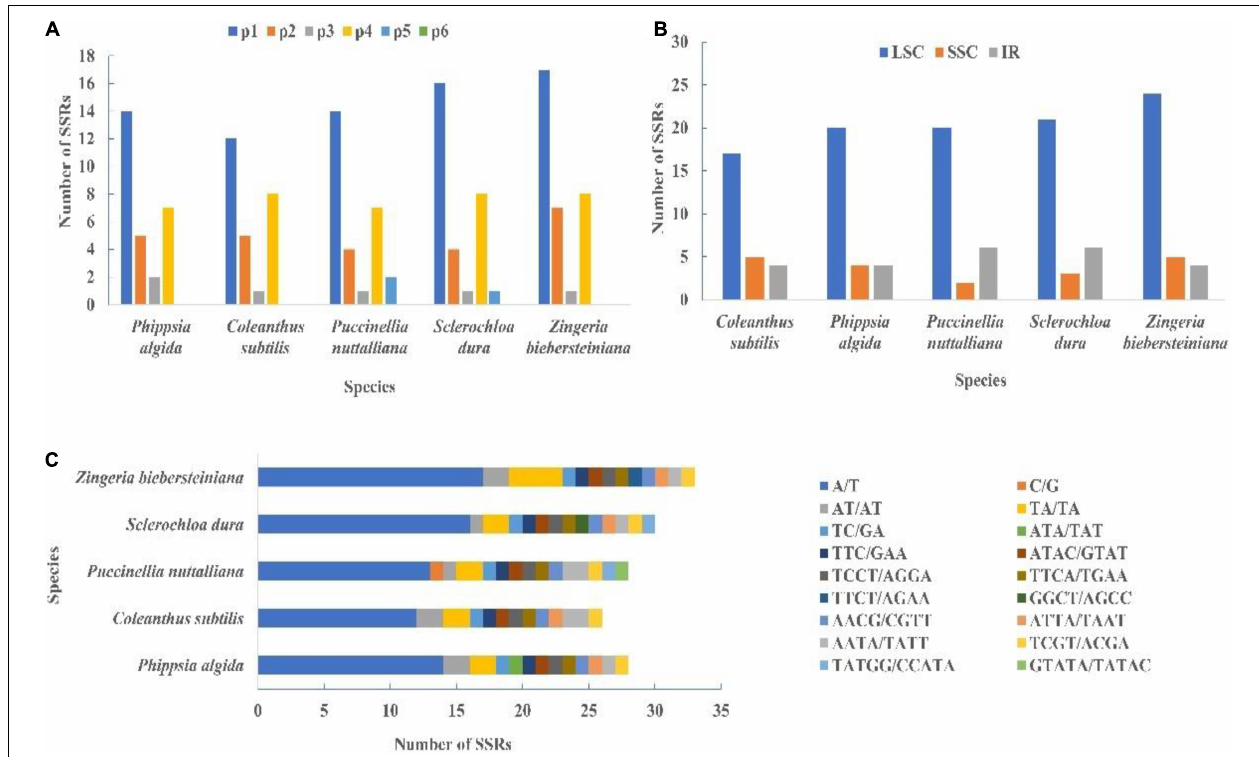
FIGURE 8 | (A) The type of SSRs in the cp genome of C . subtilis and its related species. (B) The region of SSRs in the cp genome of C . subtilis and its related species. (C) The unit of SSRs in the cp genome of C . subtilis and its related species. IR, inverted repeat; LSC, large single copy; SSC, small single copy.